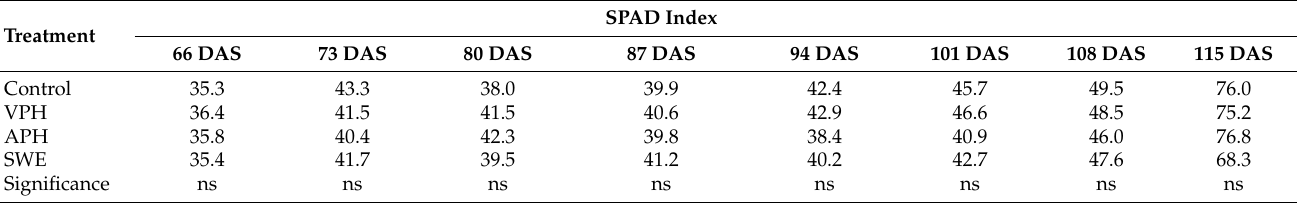
Table 1. Effect of biostimulant treatments on SPAD index of chicory leaves during the greenhouse